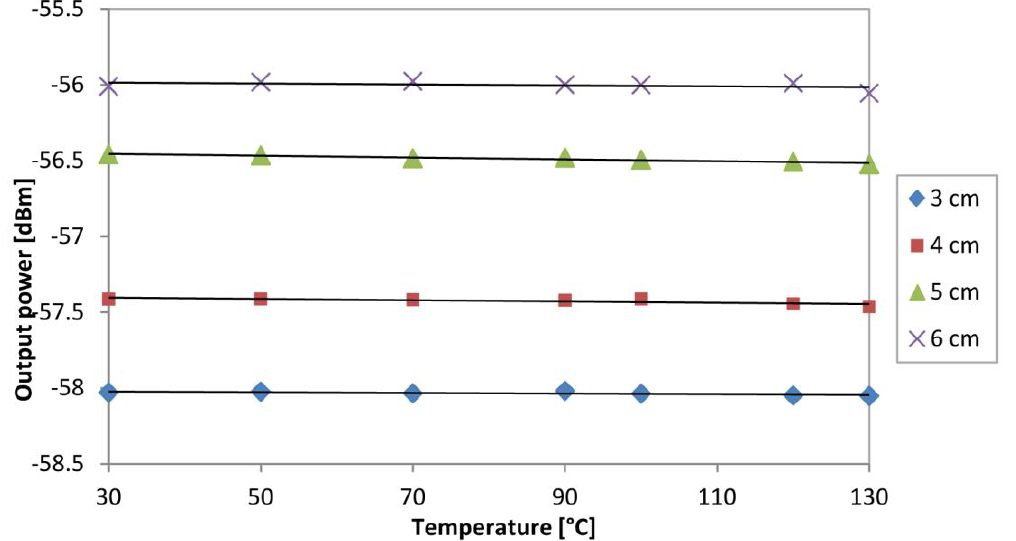
Figure 10. The output power at the peak wavelength of the ASE of 1,533 nm against temperature for different spooling